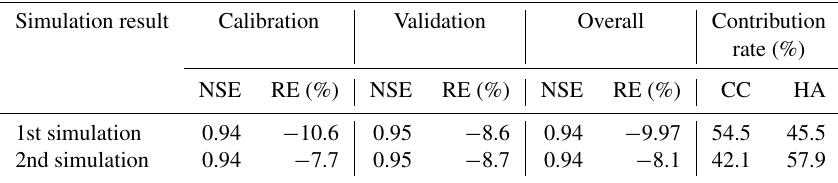
Table 7. Results of the CR of climate change and human activities for runoff changes with almost equal model performance (monthly) using the SWAT model.